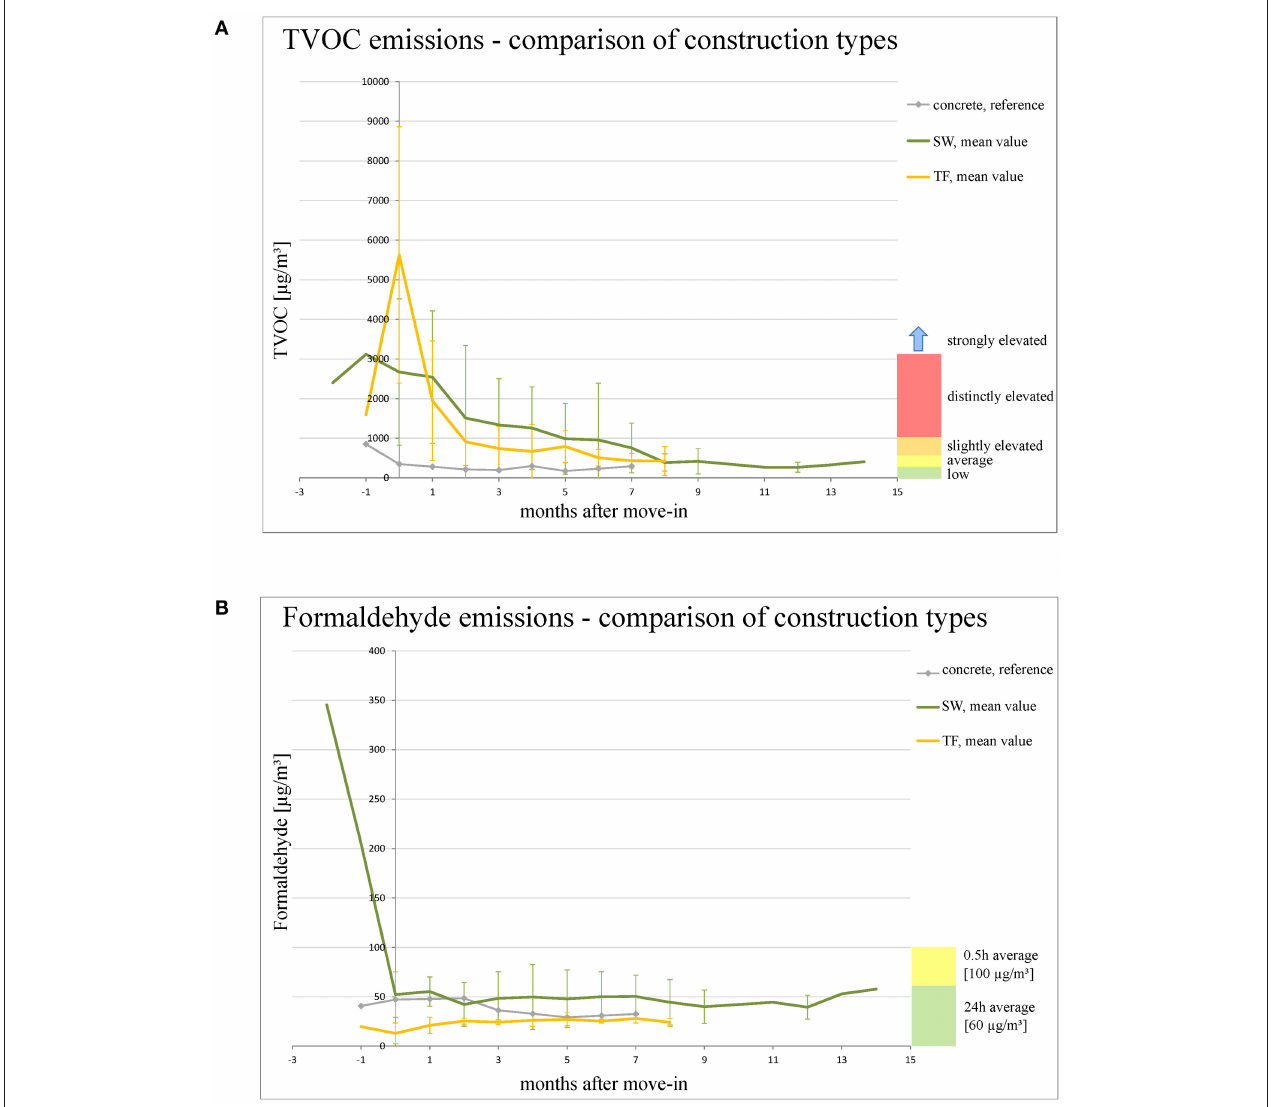
FIGURE 1 | Long-term progression of TVOC (A) and formaldehyde (B) emissions—comparison of construction